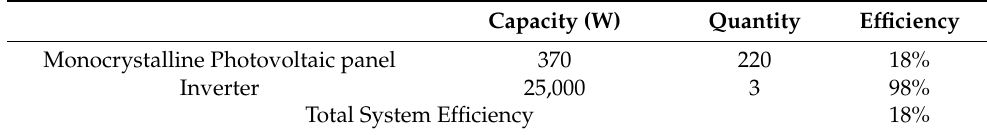
Table 12. Specifications of the installed